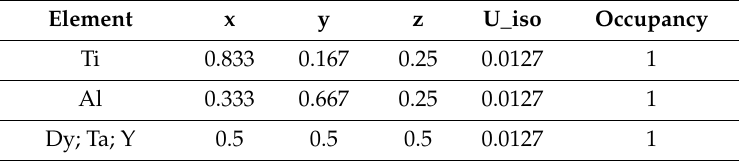
Table 6. Relative atomic coordinates in the AlTi lattice (AlTi 3 -2768) with an embedded atom Dy, Ta and Y.